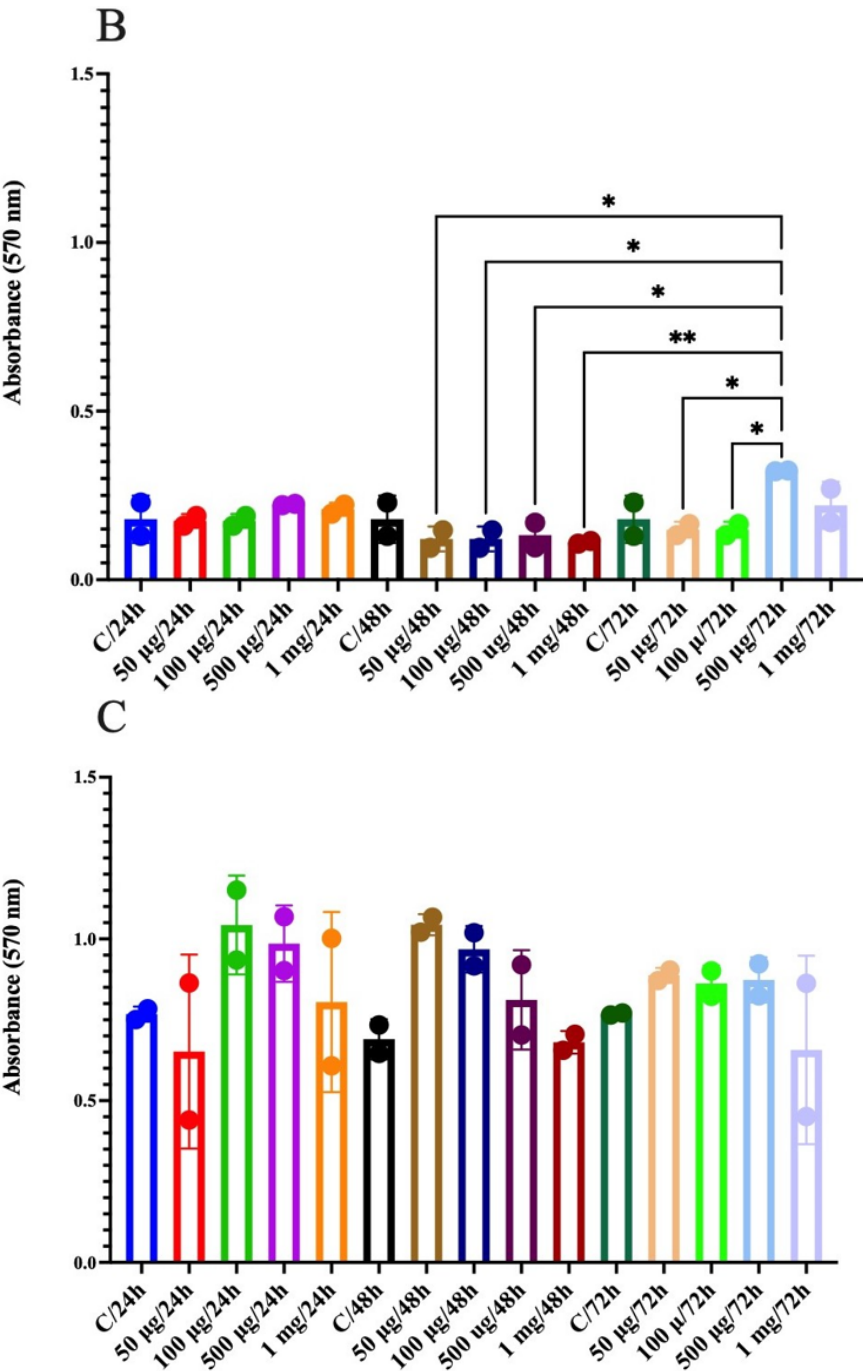
Figure 5. Cytotoxicity assay, was assessed with an MTT (thiazolyl blue tetrazolium bromide), at 24, 48 and 72 h. ( A ) CRL1831, ( B ) HT29, ( C ) SW480. (* p < 0.05, ** p < 0.01, **** p <